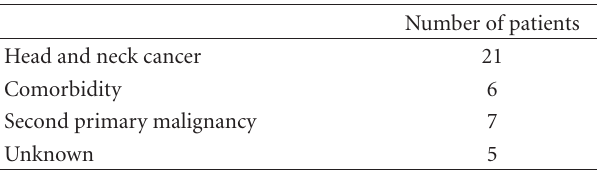
Table 2: Causes of death ( n =